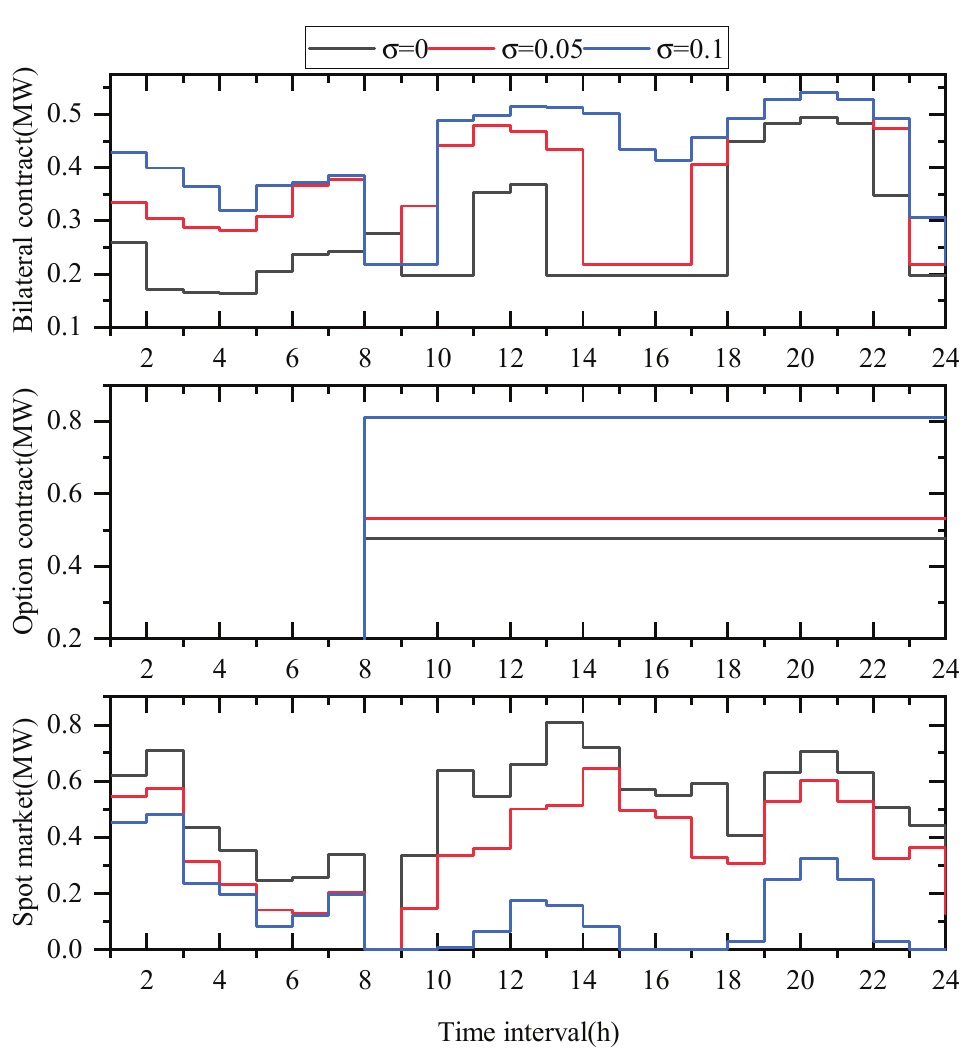
Figure 7. The change curve of electric energy trading volume with σ .